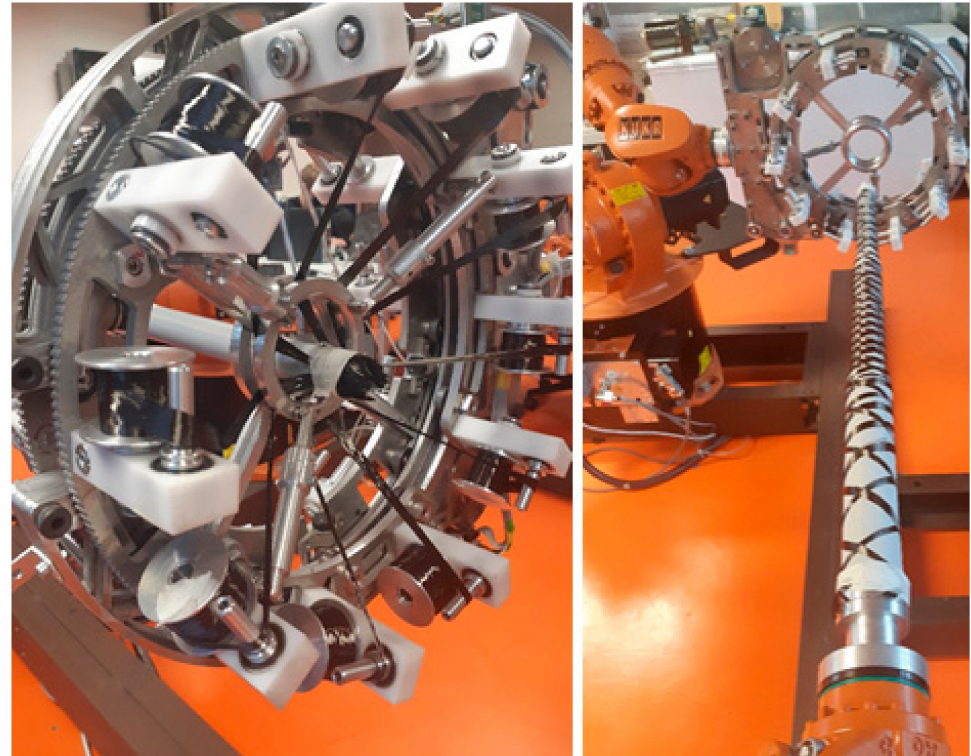
Figure 8. Detail of guide-line of the fiber-processing head containing spools with fibers before the start of winding (on the left). The resulting winding of two carbon fibers on the composite frame using two guide-lines (first guide-line winds one fiber under angle π , second winds one fiber under angle − π on three parts of the frame with different radii of cross-section 4 4 (on the